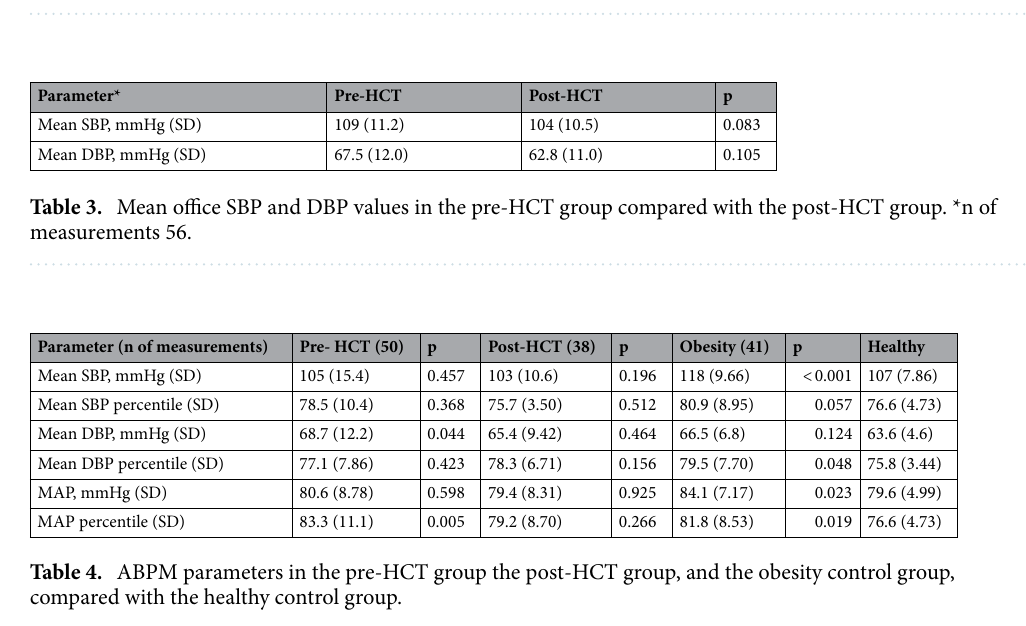
Table 2. Mean office SBP and DBP values in the pre-HCT and post-HCT groups compared with the obesity control group.